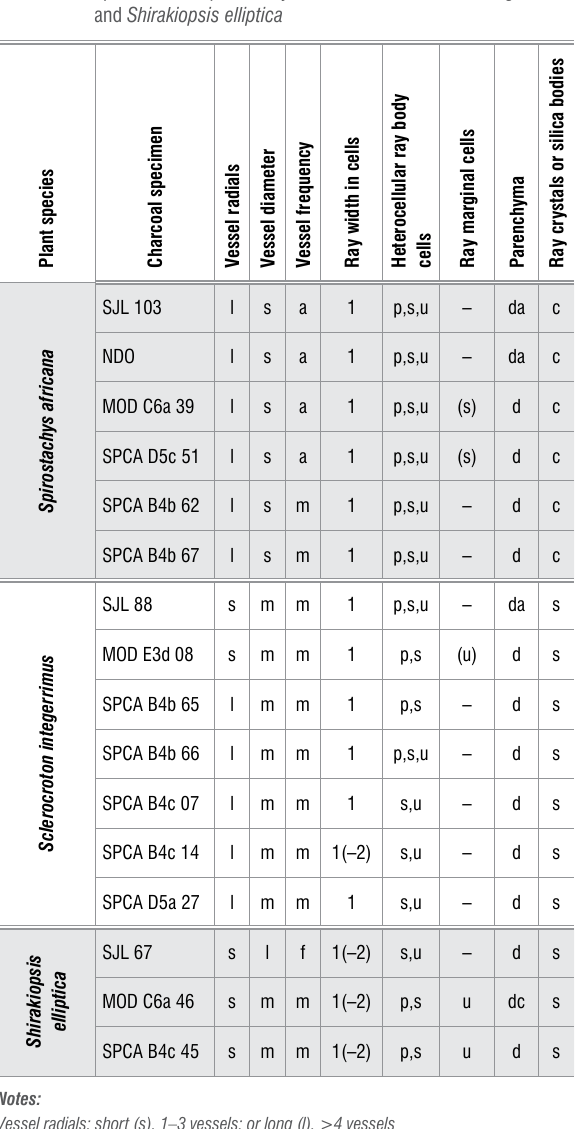
Table 1: The anatomical features of modern and archaeological charcoal specimens of Spirostachys africana, Sclerocroton integerrimus and Shirakiopsis